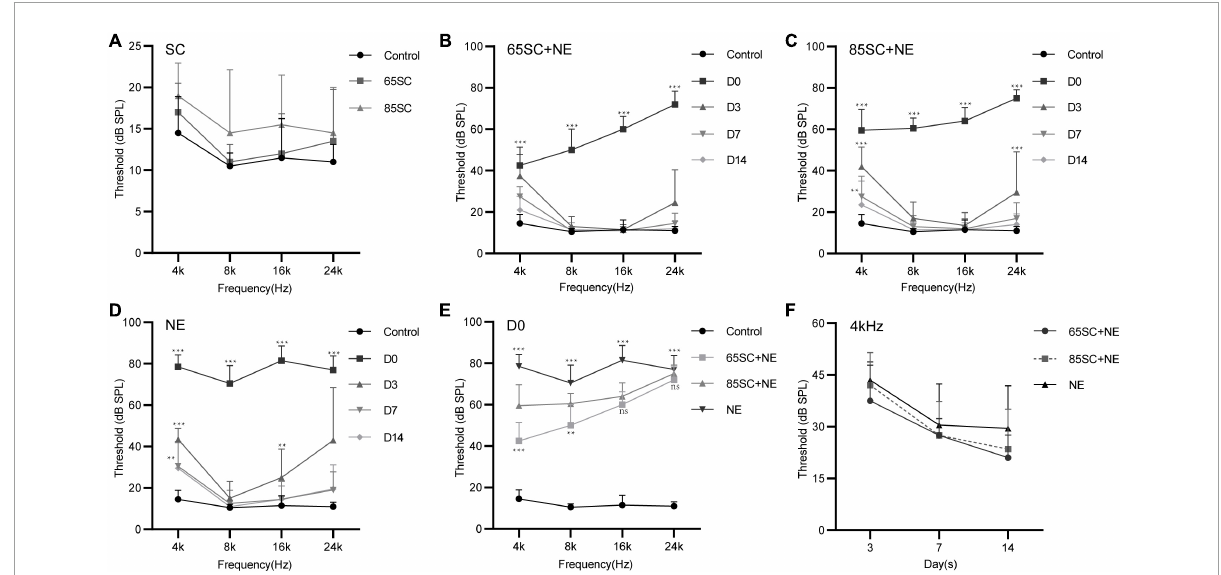
at different time points after noise exposure in the 65SC+NE group: the highest hearing threshold was at D0 ( p < 0.001), and hearing thresholds returned to normal at D14 ( p > 0.05). (C) Changes in ABR thresholds at various time points after noise exposure in the 85SC+NE group: the highest threshold was at D0 ( p < 0.001), and hearing thresholds returned to normal at D14 ( p > 0.05). (D) ABR thresholds in the NE group at each time point after noise exposure: the highest threshold was at D0 ( p < 0.001), and hearing thresholds returned to normal at D14 except 4 kHz frequency ( p > 0.05). (E) Comparison of ABR thresholds in the control and experimental groups at D0. Sound conditioning contributed to hearing protection immediately after noise exposure, and hearing protection in the 65SC+NE group was superior to that in the 85SC+NE group, primarily at 4 and 8 kHz frequencies. (F) The 65SC+NE, 85SC+NE, and NE groups were more seriously affected by noise at 4 kHz. ** p < 0.01, *** p < 0.001.